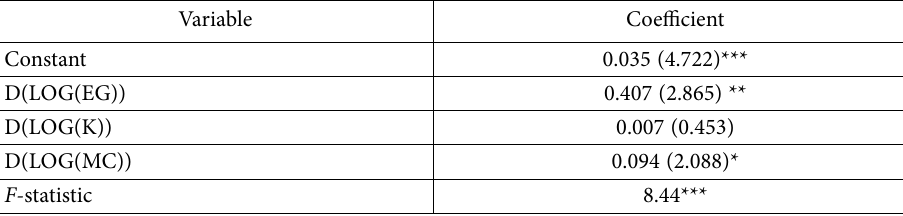
Figure 6. Response of variables to innovations – the impulses are equal to non-factorized standard deviation (source: authors’ own Table 4. OLS regression results (source: authors’ own processing)